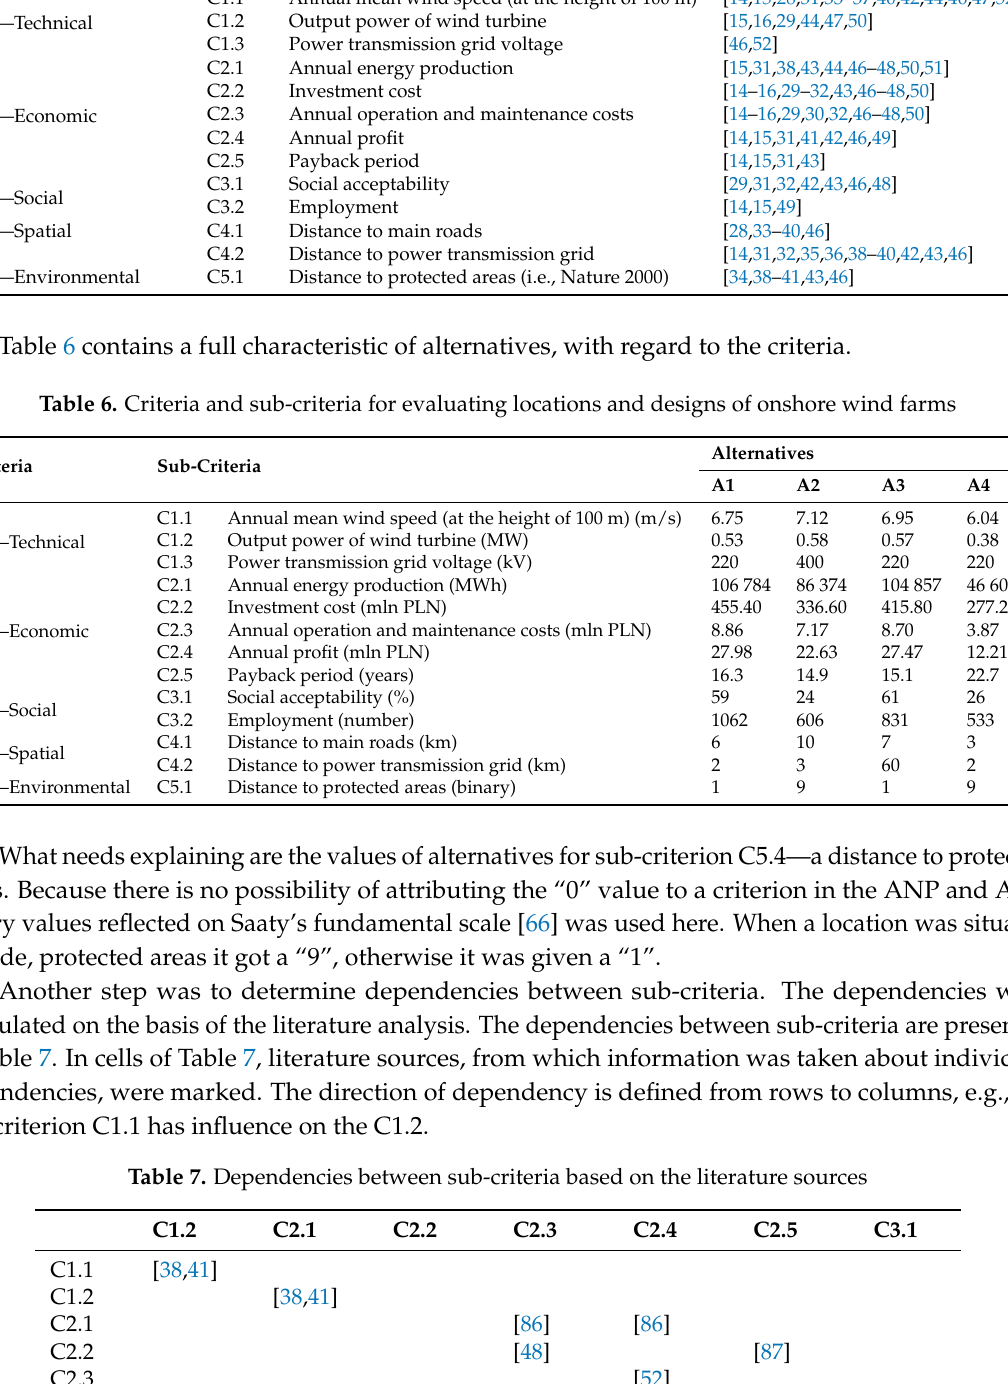
Table 5. Criteria and sub-criteria for evaluating locations and designs of onshore wind farms. Criteria